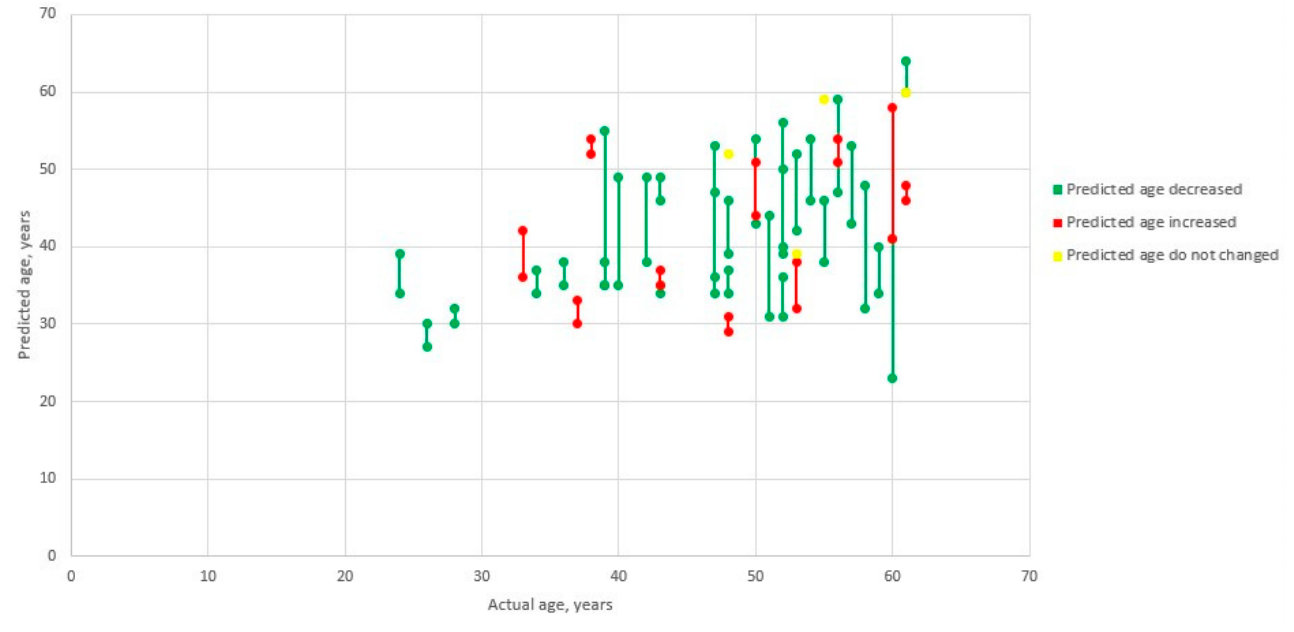
Figure 1. Predicted biological age data rows. Weight and body mass index of patients were analyzed. Patients’ weight at arrival was in the range of 54–150 kg, mean value is 83 kg. The body mass index (BMI) was in the range 20.02–38.63 and mean value is 27.13. Patients’ weight at departure was in range of 51–145 kg, mean value is 80 kg. The body mass index (BMI) was in the range 19.2–37.23 and mean value is 26.86. Nobody increased his or her weight. Only one patient had a BMI 19.2 considered as a weight deficiency at departure. The group of those who decrease biological age has a mean BMI value 28.68 (in range of 20.08–28.63) and mean value of weight drop is 4 kg. The group of patients who increase biological age has a mean BMI value 23.74 (in the range of 20.02–29.07) and mean value of weight drop is 2 kg. Pearson’s linear correlation coefficient between weight (BMI) and changes of biological age is − 0.47 and − 0.5,